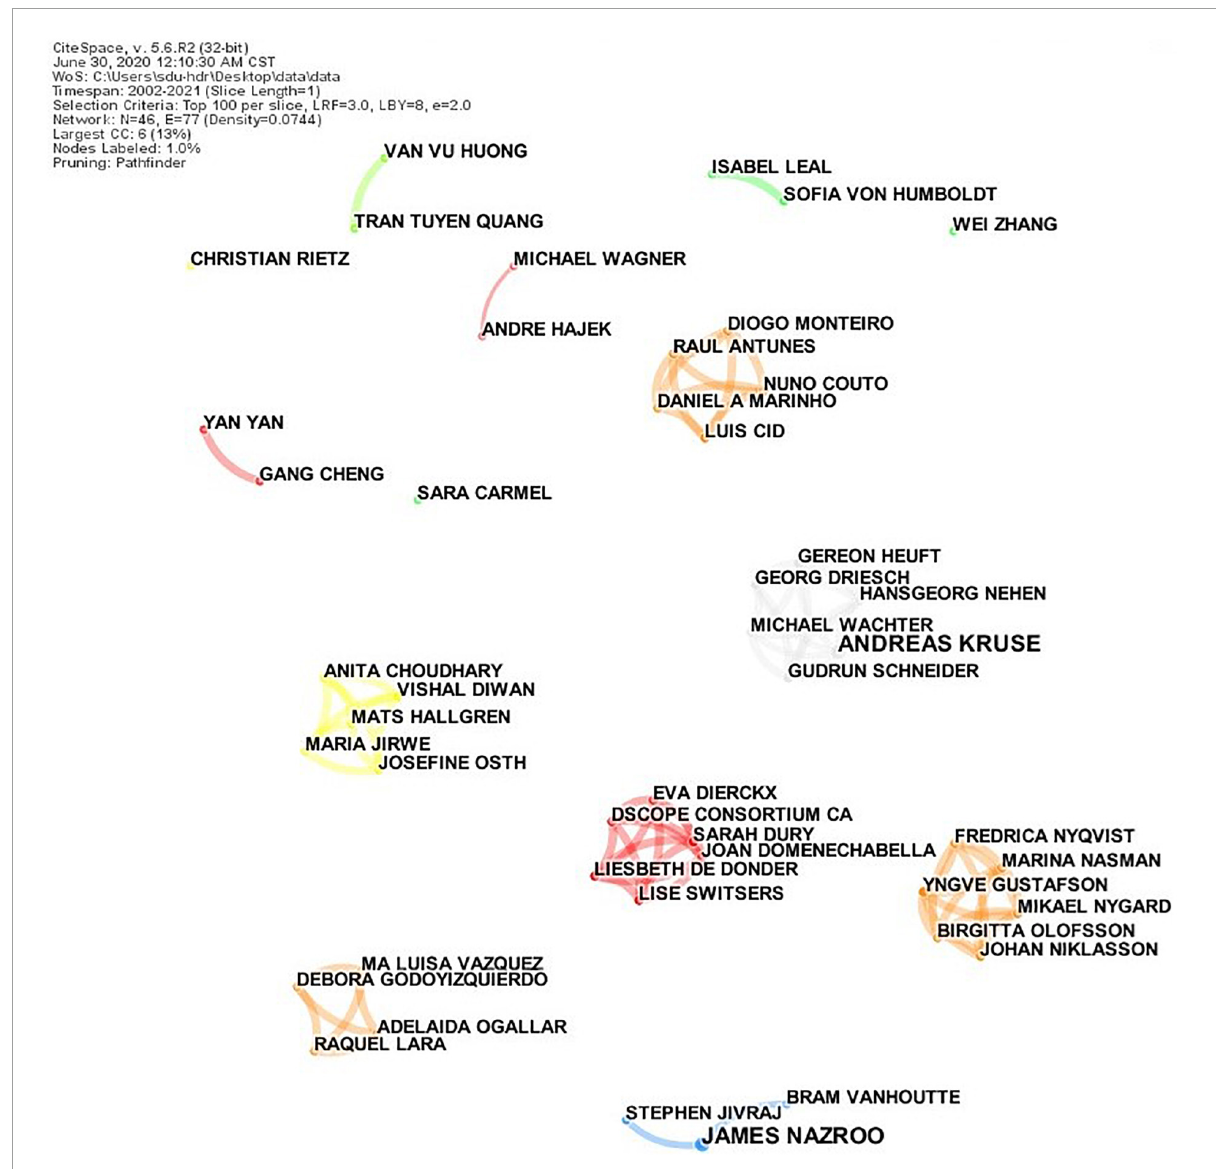
FIGURE4 Co-authorship network of authors. A circle represents an author, and the size of the circle represents the frequency of publications. The line between nodes represents the collaboration relationship, and the thickness of the line represents the frequency of